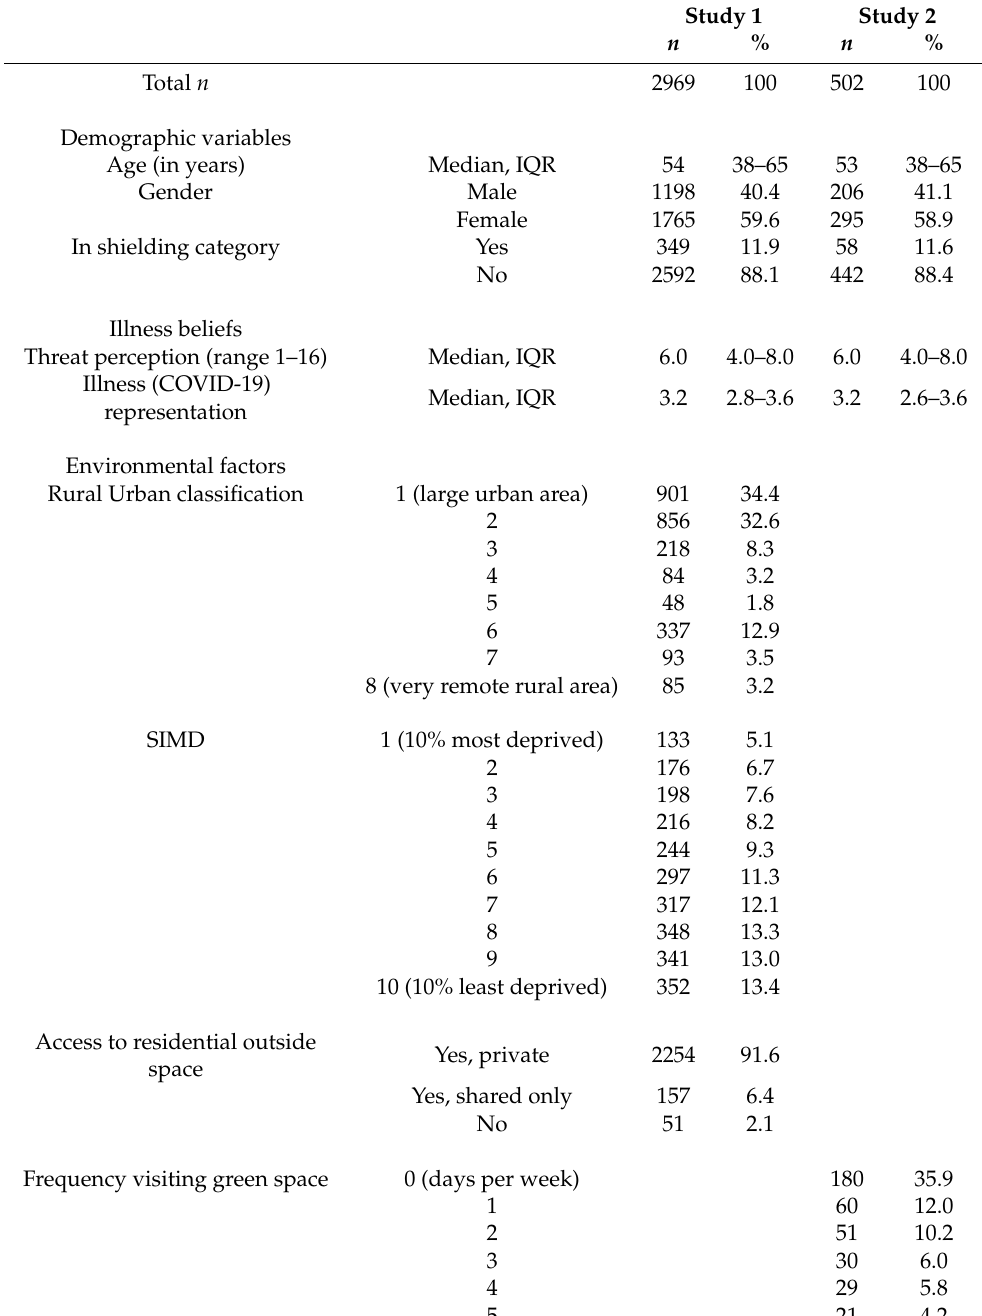
Table 1. Characteristics of people who participated in Study 1 and